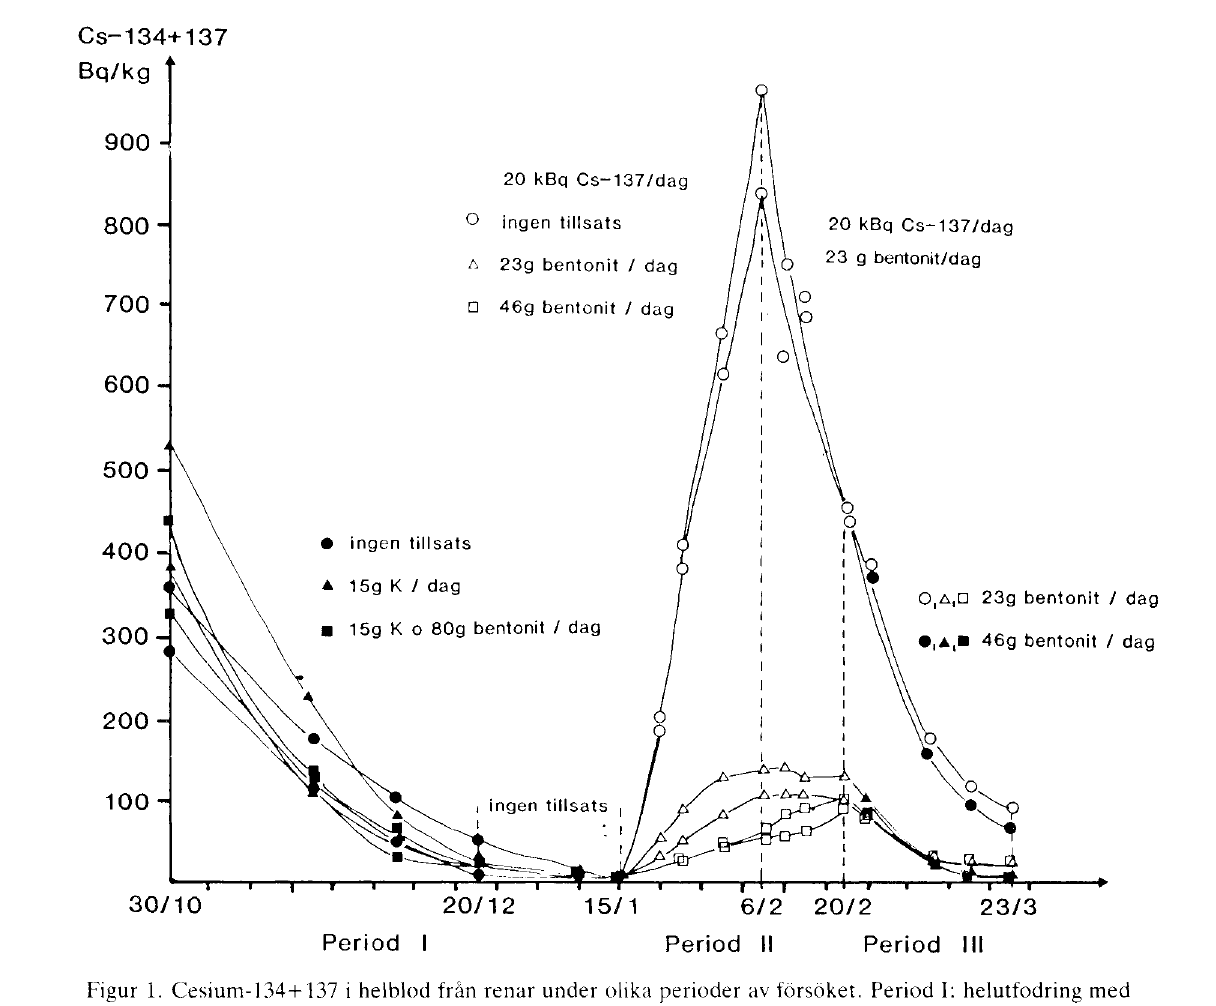
Figur 1. Cesium-134+137 i helblod från renar under olika perioder av forsoket. Period I: helutfodring med tillskott av kalium eller kalium + bentonit. Period II: utfodring med radioaktivt kontaminerad lav (20 kBq Cs-137/dag) i kombination med foder innehållande olika mangder bentonit. Period III: helutfo dring med tillskott av bentonit på två olika nivåer. Figure 1. Radiocesium (134+137) in blood from reindeer during different parts of the experiment. Period I: When feeding pellets and no supplements or supplements of K or K + bentonite. Period II: When